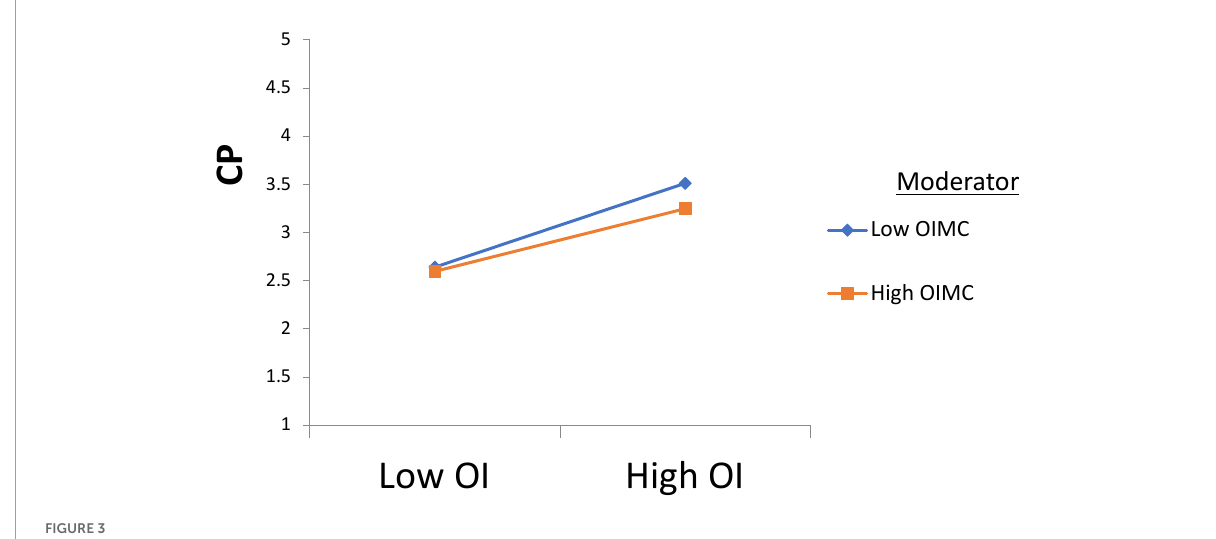
FIGURE3 Moderation effect 1. OI, Open Innovation; CP, Commercialization Performance; OIMC, Open Innovation Model Constraints.